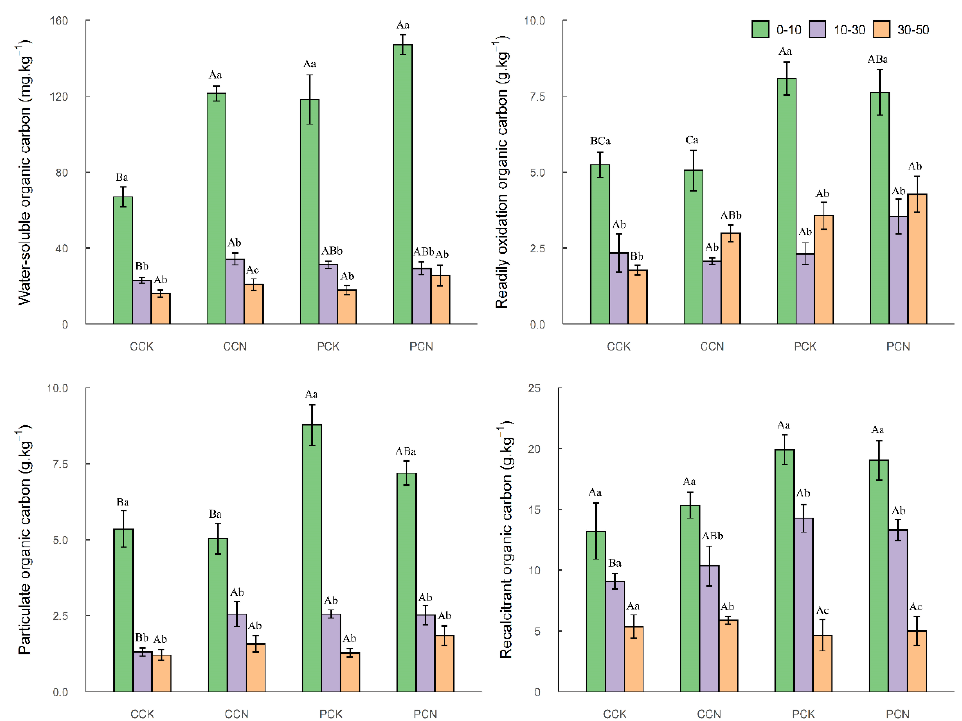
Figure 1. Characteristics of soil organic carbon fractions after close-to-nature transformation. CCK, CCN, PCK, and PCN represent the control and close-to-nature transformation of C. lanceolata plan- tation and the control and close-to-nature transformation of P. massoniana plantation, respectively. Different small letters meant significant differences among different soil layers in the same stands, and different capital letters meant significant differences among different stands in the same soil layers at p < 0.05.